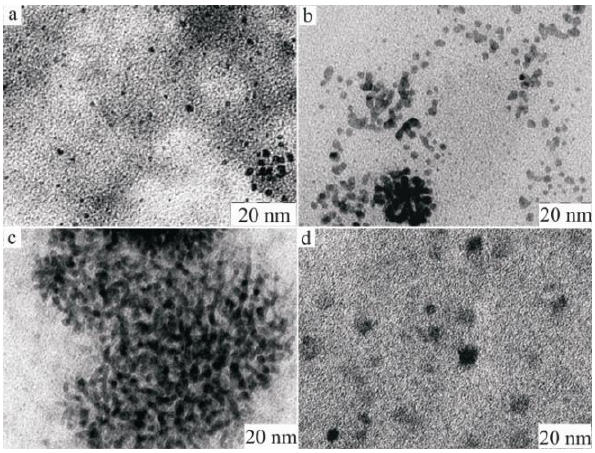
Figure 5. TEM images of the PdNPs before (a) and after ( (b) for a liquid phase; (c) for the precipitated phase) the Suzuki-Miyaura reactions and after interaction of the catalyst with m- iodobenzoic acid at the presence of KOH in water (d) .